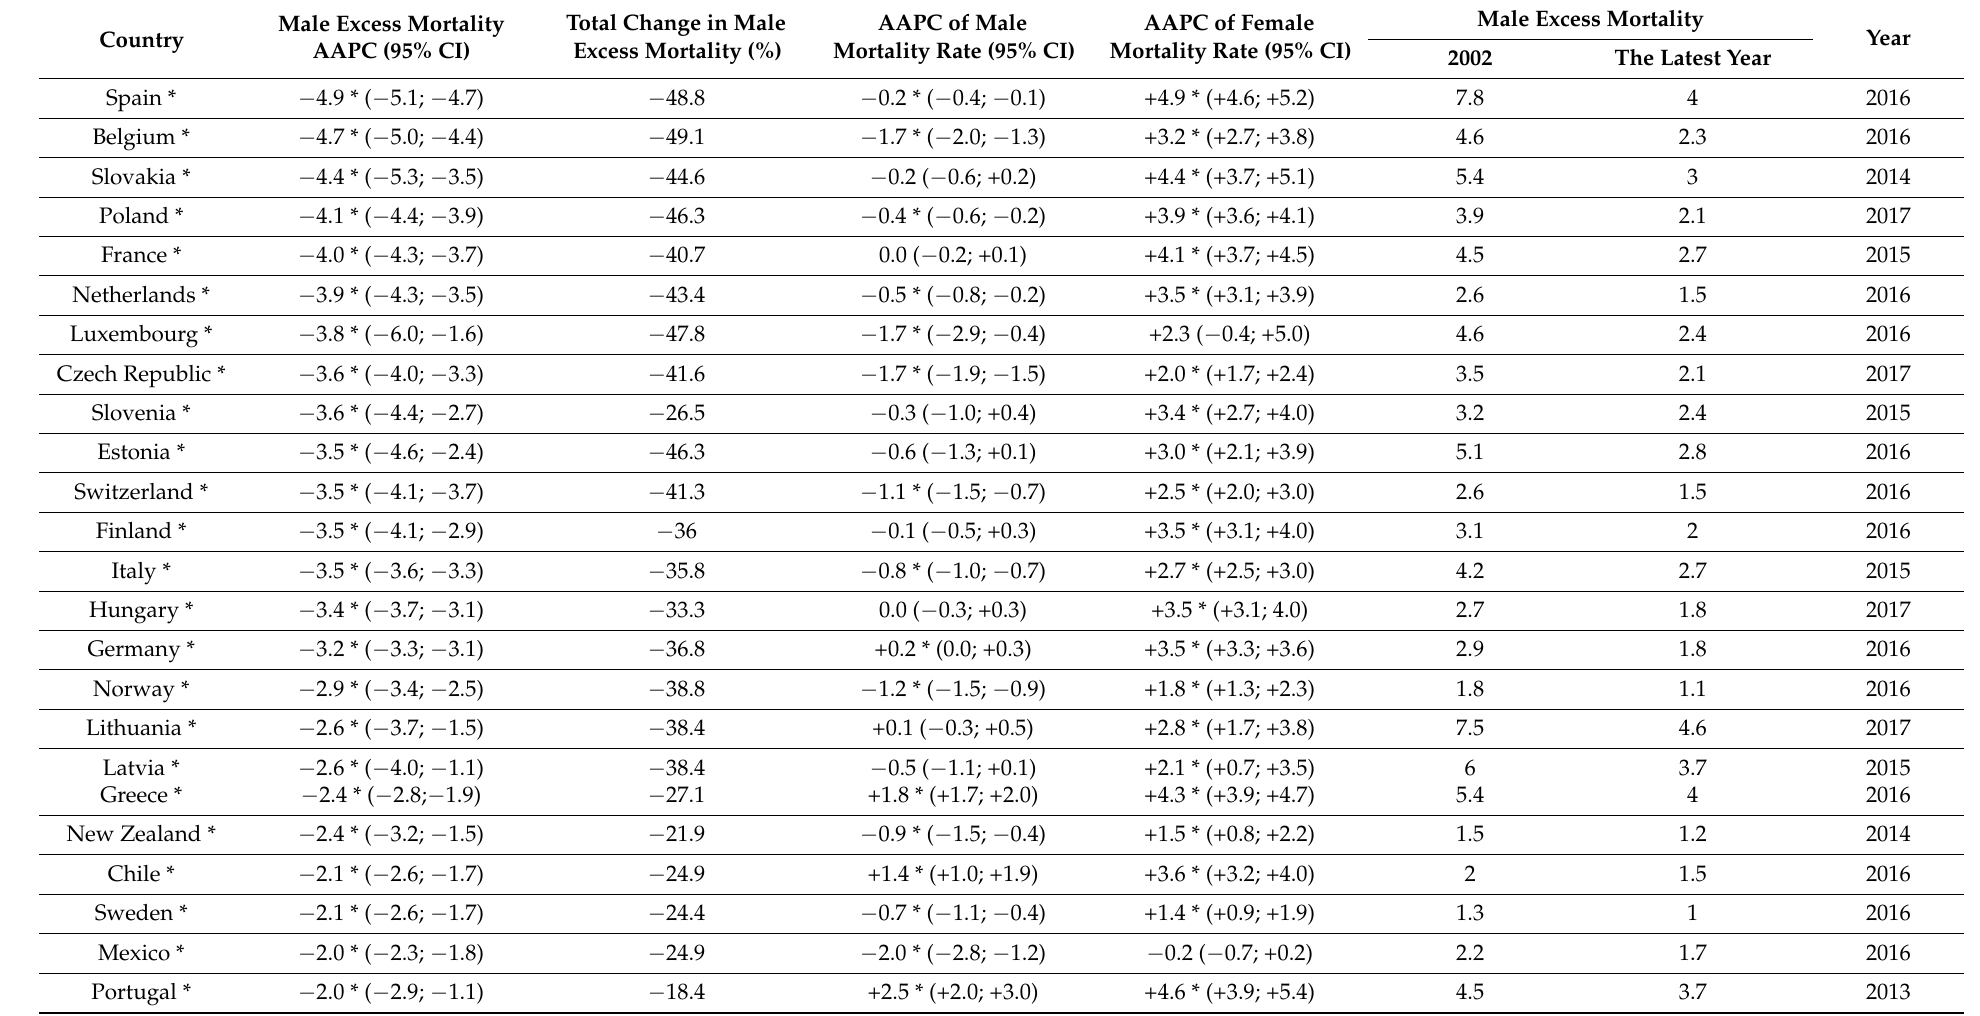
Table 1. Male excess mortality due to lung cancer in OECD countries from 2002 to